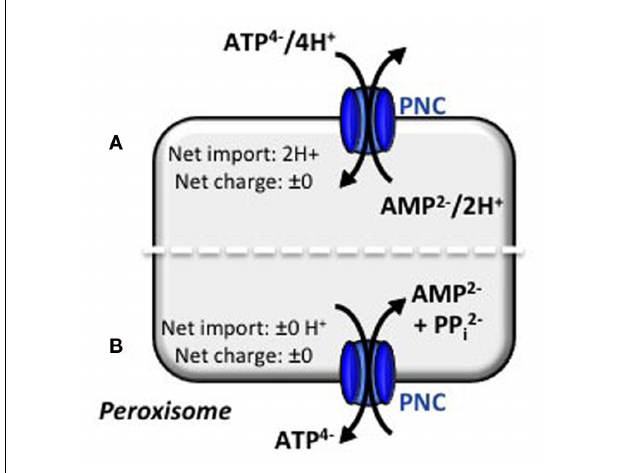
FIGURE 2 | Electroneutral transport mechanisms for the peroxisomal ATP carrier. Based on the literature concerning similar transport mechanisms, two modes of transport actions for ATP can be hypothesized. (A) Electroneutral ATP/AMP counter-exchange is accomplished by co-transport of protons.The import of 2H + must be compensated by the Donnan equilibrium. (B) Electroneutral ATP/AMP counter-exchange is maintained by a three substrate-model. AMP and PP i are exchanged for ATP and no proton net import is needed. Both models are under investigation (N. Linka, personal